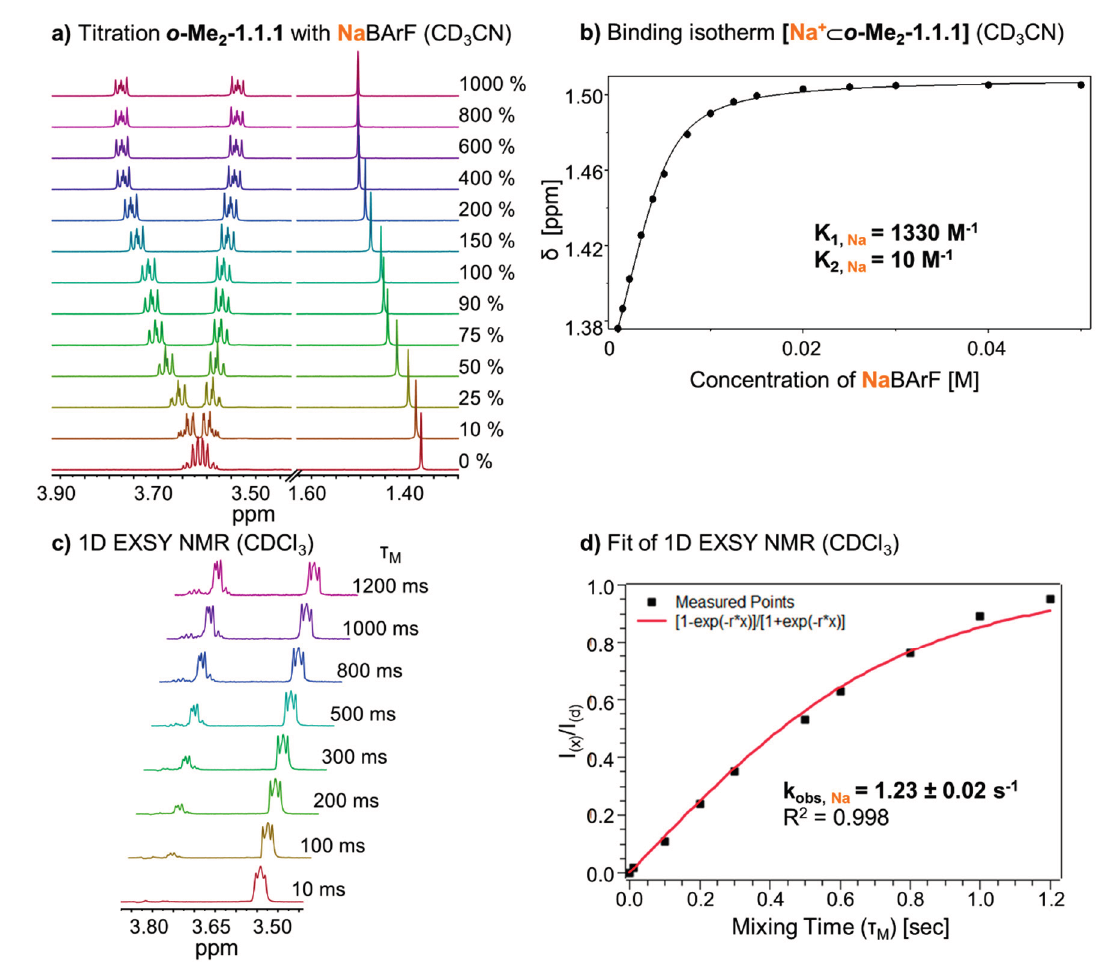
Figure 3. ( a ) Partial 1 H NMR (400 MHz, 298 K, CD 3 CN) stack plot of o -Me